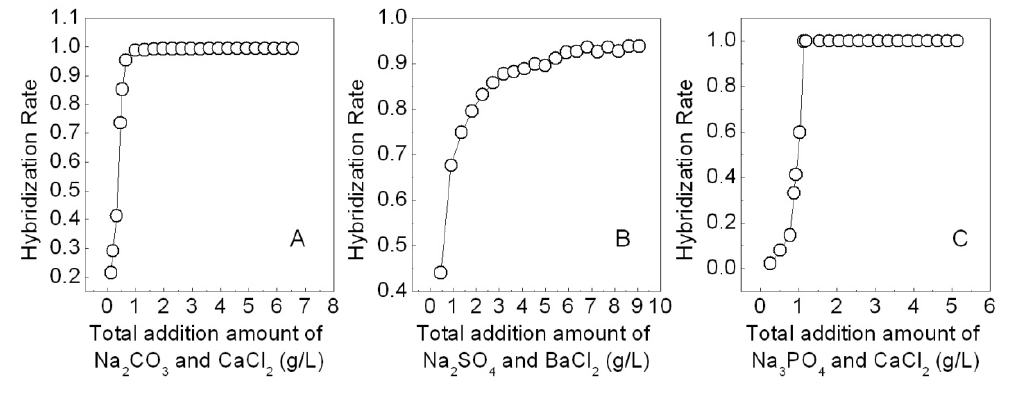
Figure 2. Effects of the addition amount of Na hybridization of APRB ( A ), Na of MB ( B ), and Na ABB6B ( C